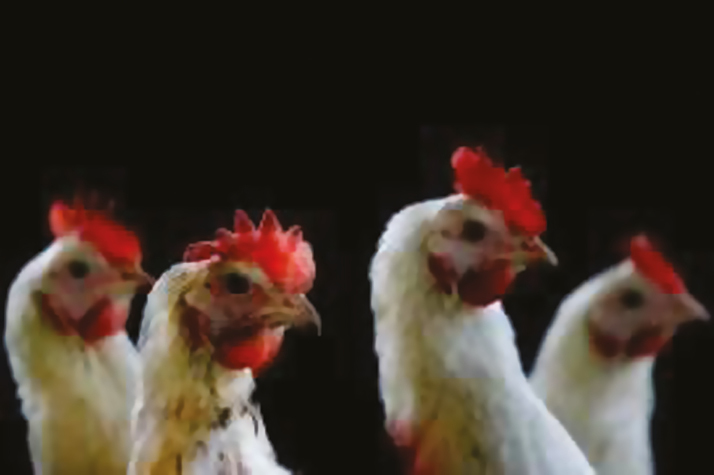
(a) Source: Distrifood